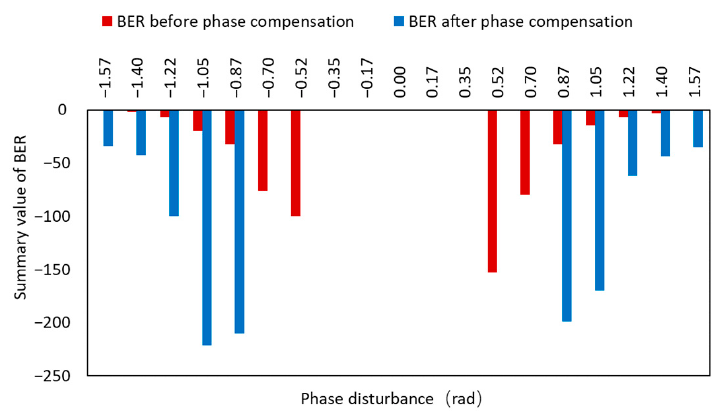
Figure 13. BER before and after phase compensation.